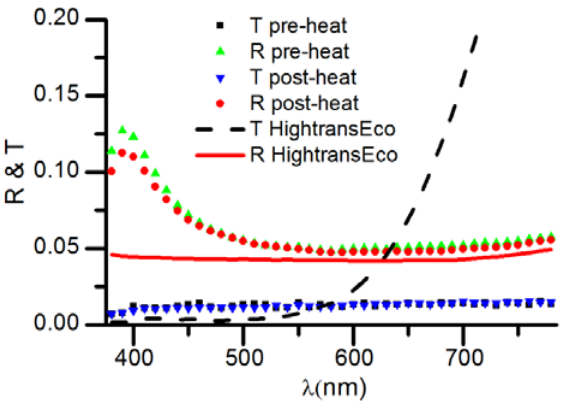
Figure 7. Effect of abandonment test on transmittance and reflectance spectra of navy/black coatings with SiAlN x and Sst layers. Experimental data of coatings (points) and Schott Ceran HightransEco (lines).